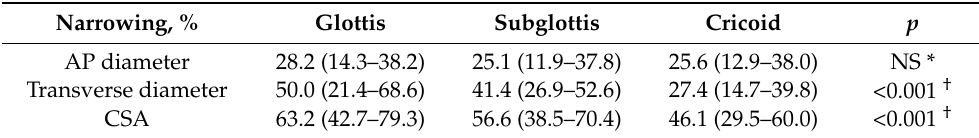
Table 3. Level-based differences in the percentages of croup-related